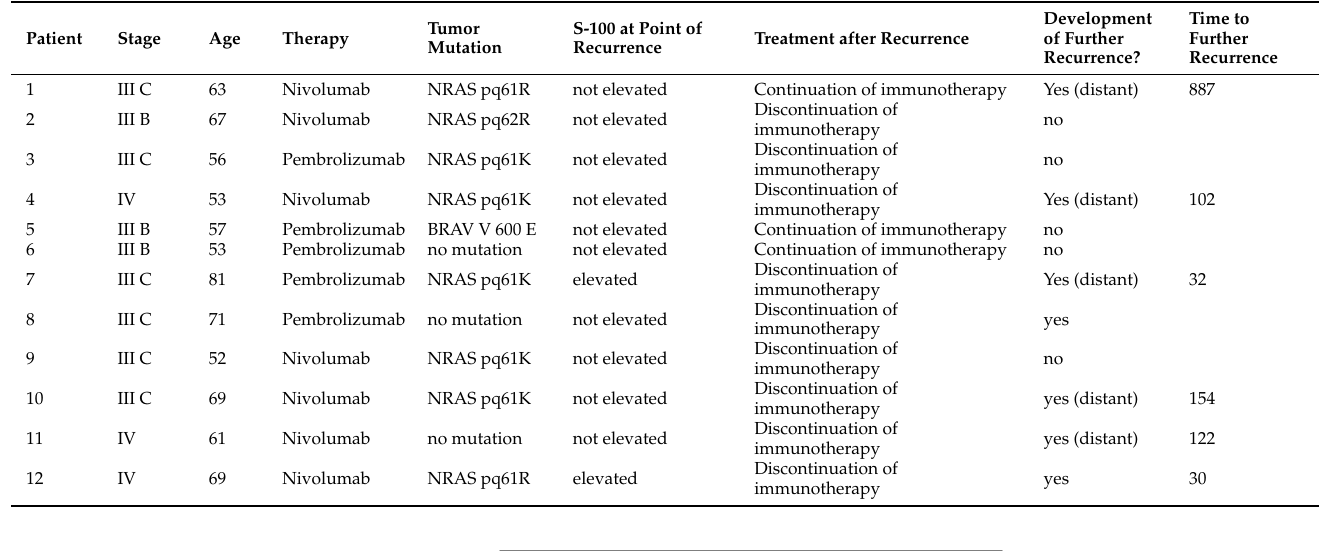
Table 1. Overview of the patients.